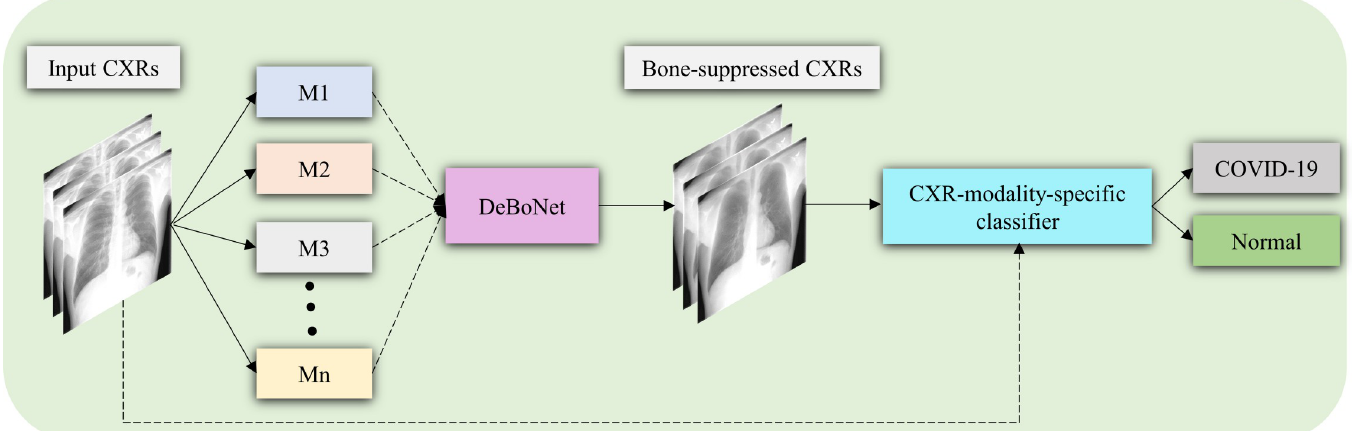
Fig 1. Graphical abstract of the proposal. Several proposed bone suppression models (M1, M2, ... , M n , n = 1, 2, ... , 14) are trained on a set of input CXRs. The predictions of the top-3 performing bone suppression models are combined using a majority voting approach to construct DeBoNet. A classification model is trained on the non-bone-suppressed and bone-suppressed images to classify them into COVID-19 or normal categories.